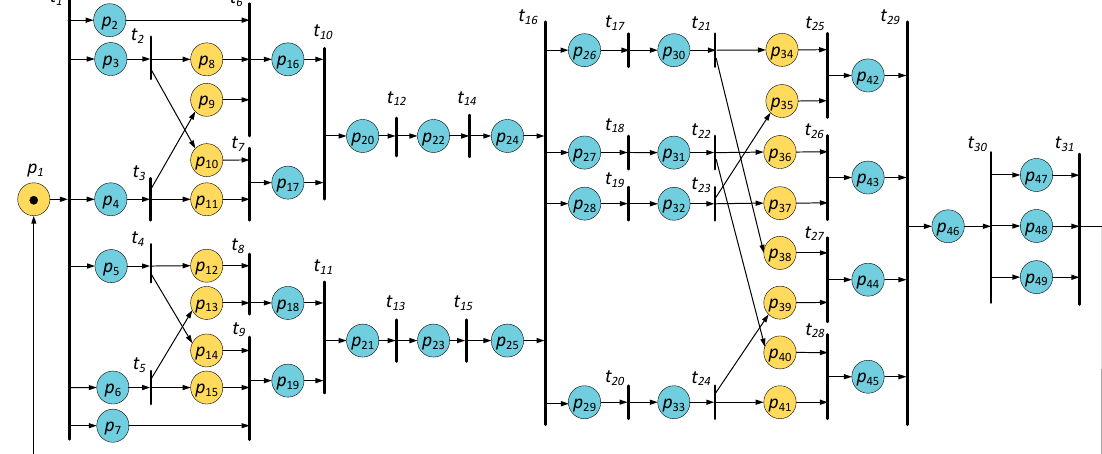
Figure 5. Petri net-based description of the presented direct matrix converter.